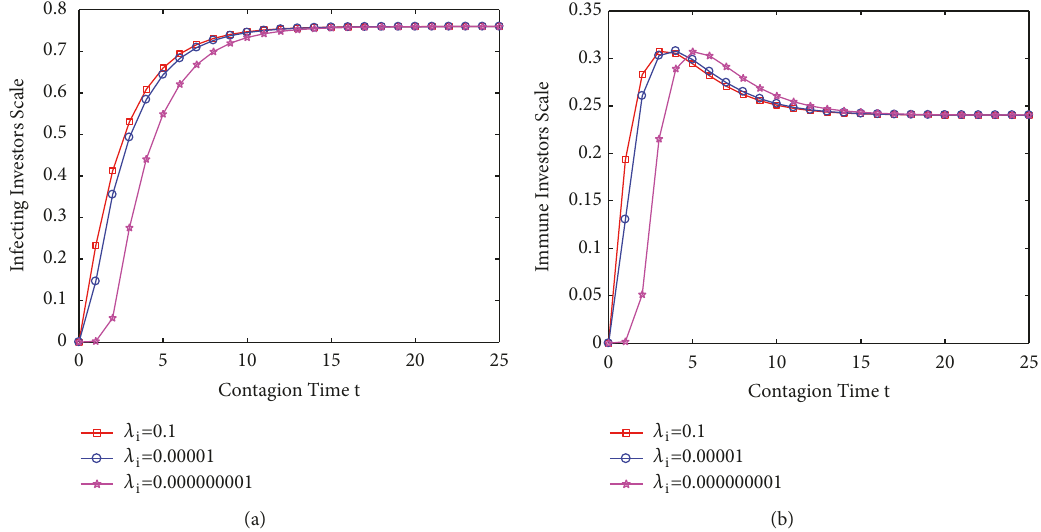
Figure 11: Changes in the scale of infecting investors and immune investors with the contagion time under different investor influence 𝜆 𝑖 .